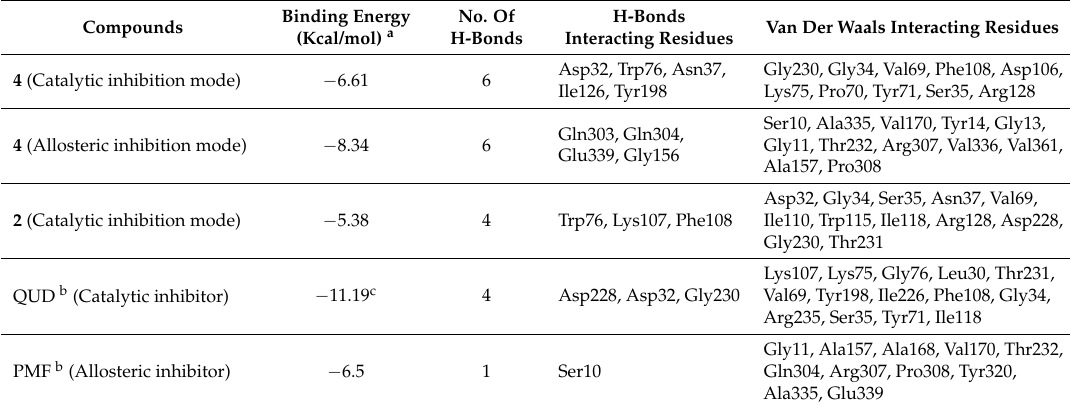
Table 3. Docking affinity scores and possible H-bond formation to BACE1 (2wjo) active sites by 4 and 2 along with reported inhibitors. Binding Energy No. Of H-Bonds Compounds Van Der Waals Interacting Residues (Kcal/mol) a H-Bonds Interacting Residues Asp32, Trp76, Asn37, Gly230, Gly34, Val69, Phe108, Asp106, 4 (Catalytic inhibition mode) − 6.61 6 Ile126, Tyr198 Lys75, Pro70, Tyr71, Ser35, Arg128 − 8.34